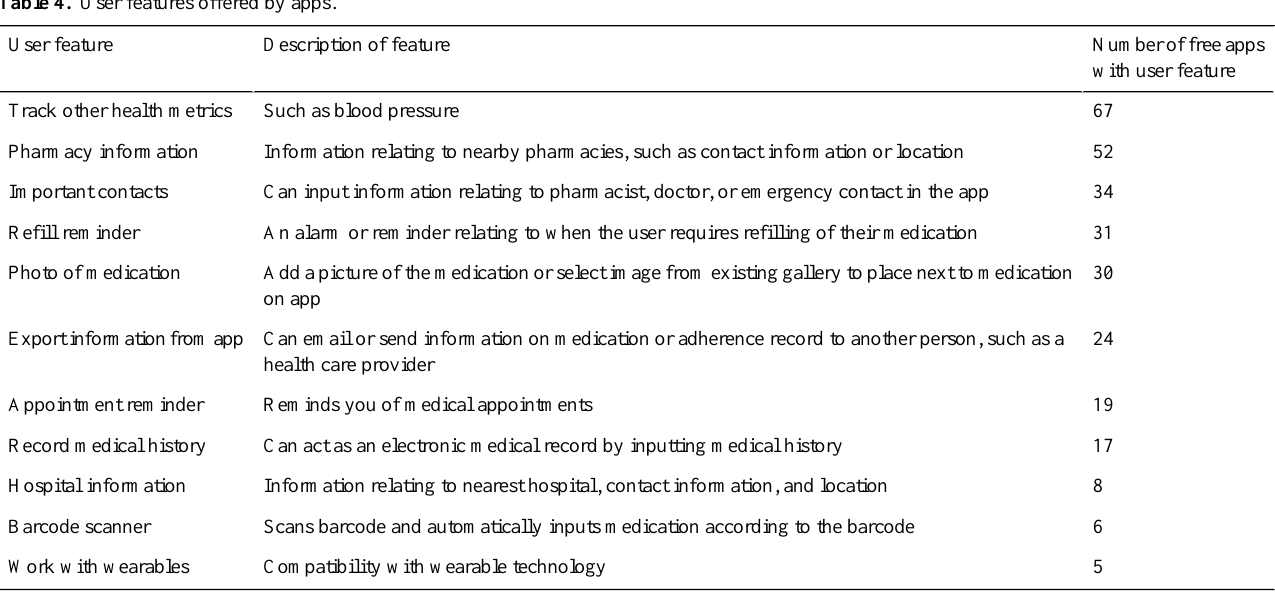
Table 4. User features offered by